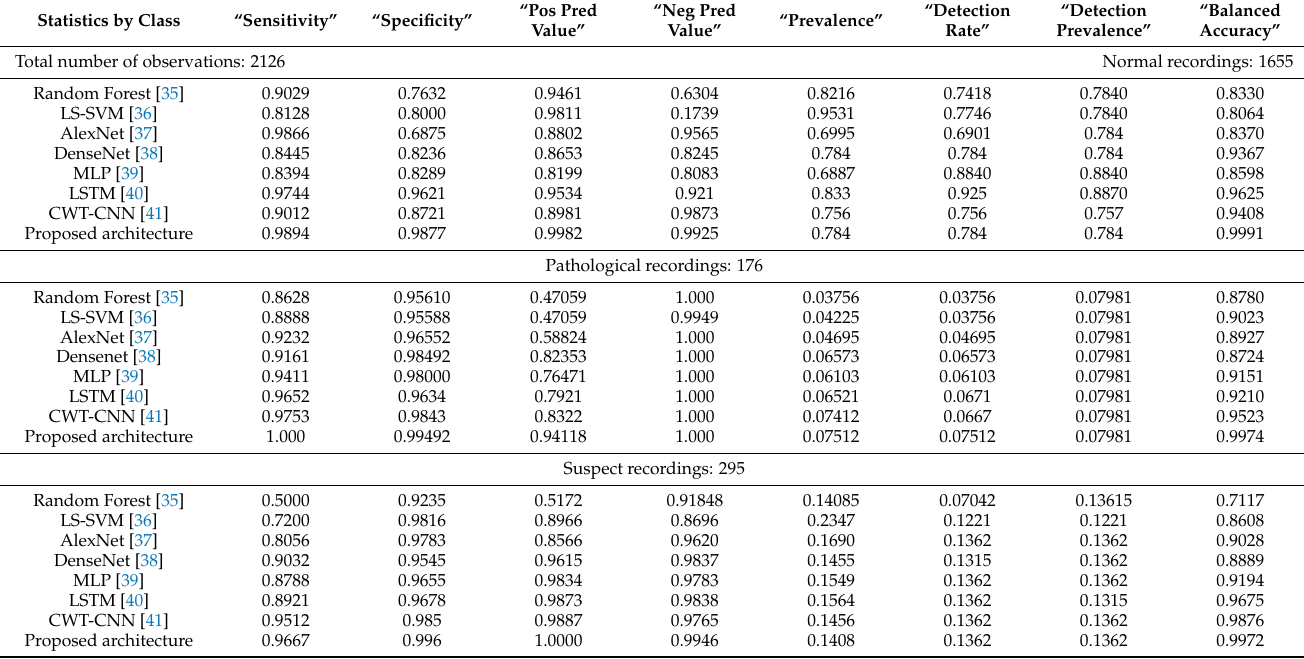
Table 1. Performance indices of the proposed method routine with other leading methods on the same CTG